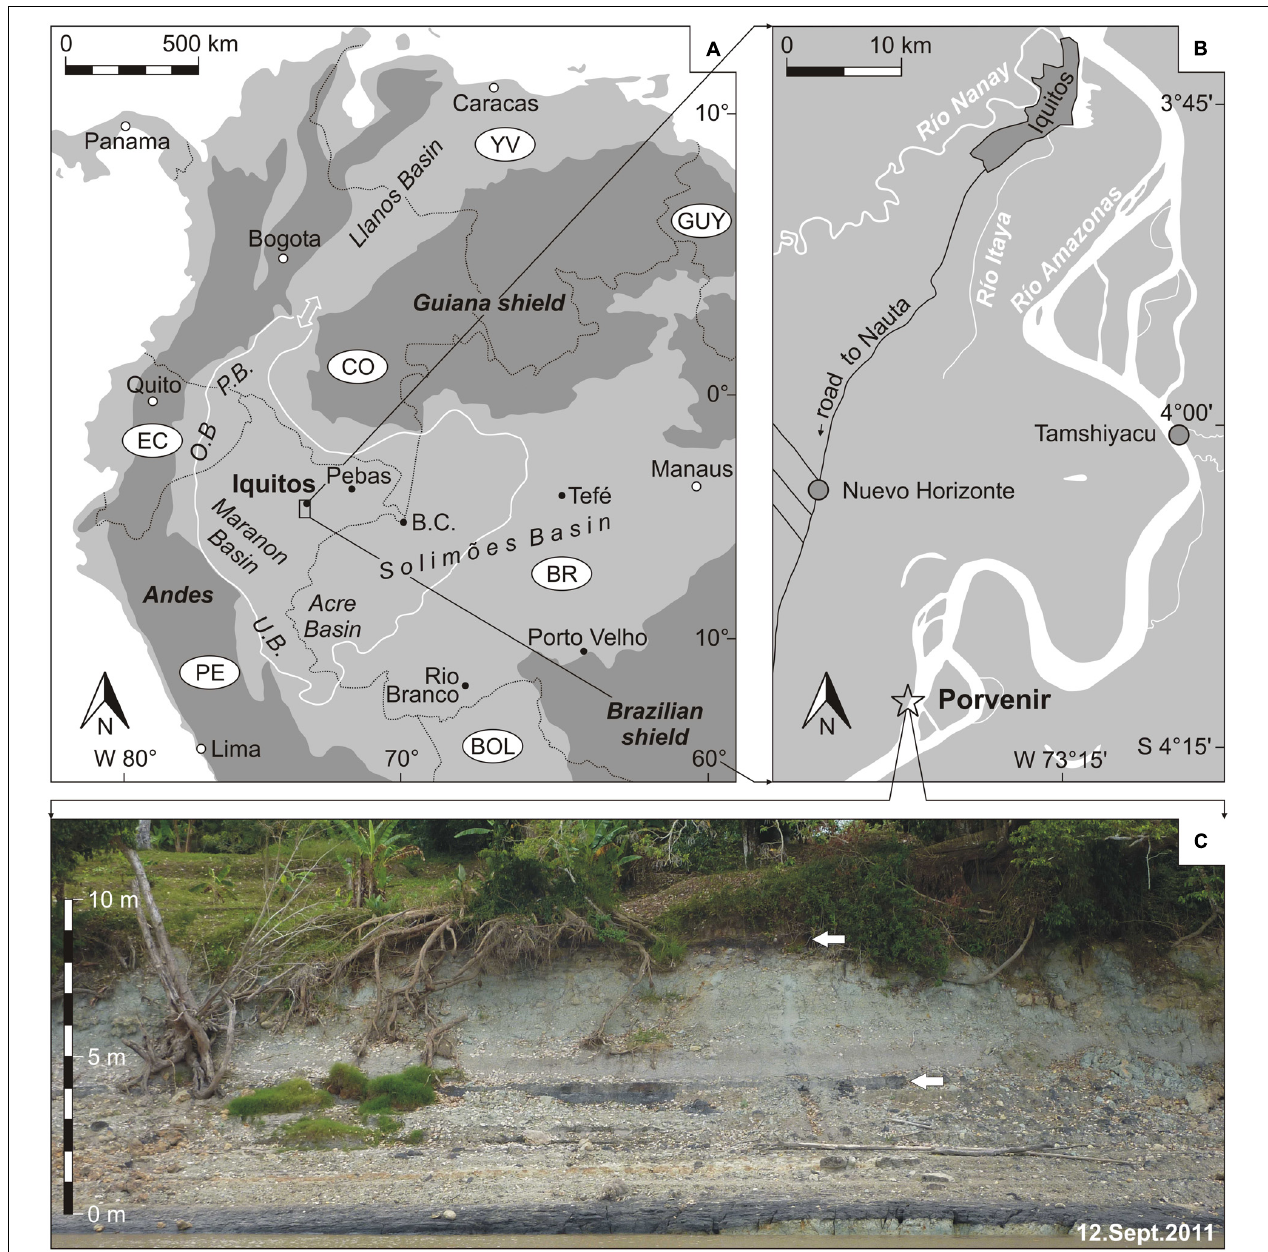
FIGURE 1 | Location of the investigated outcrop Porvenir in NE-Peru. (A) Overview map of northern South America (white line marks the maximal extend of the Pebas wetland during the middle Miocene; double arrow indicates the most favored marine connection through the Llanos Basin; BC = Benjamin Constant, OB = Oriente Basin, PB = Putumayo Basin, UB = Ucayali Basin; adapted from Wesselingh, 2008). (B) Location of the village Porvenir, south of Iquitos (modified from Gross and Piller, 2019). (C) Outcrop photograph of the Porvenir section [field of view ∼ 40 m; arrows indicate lignite layers (beds 5 and 10), see Figure 2